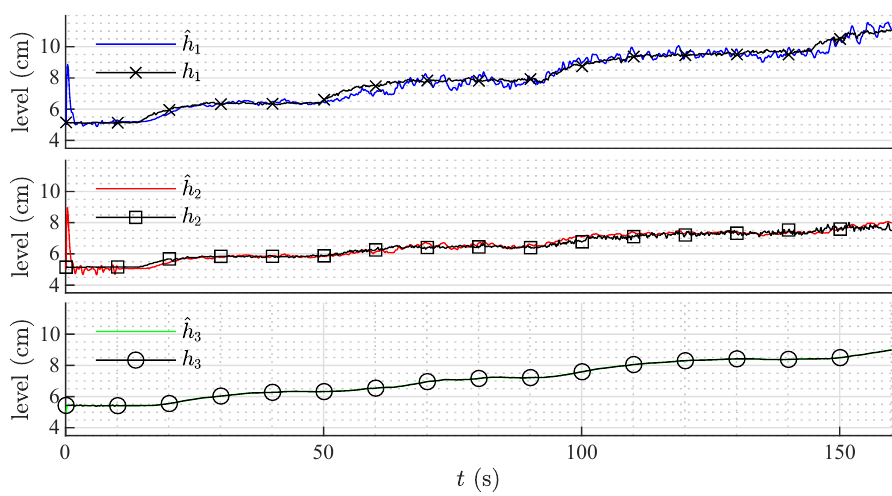
Figure 15. High-Gain Observer performance: 30% variation in all constant parameters.